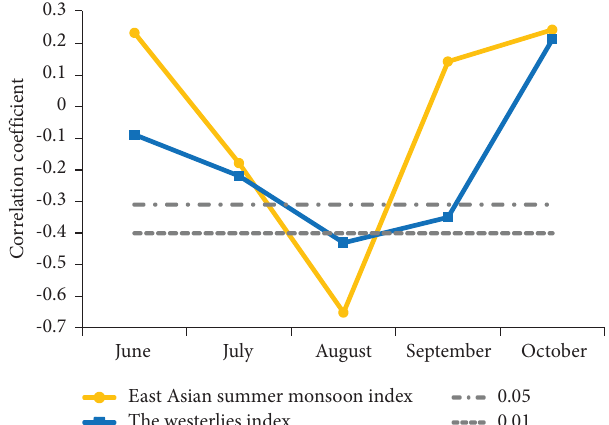
Figure 2: Te monthly corresponding correlation coefcient between the AHS index of TP and the EASWJ index and the EASM index from 1981 to 2020 (dotted line is confdence